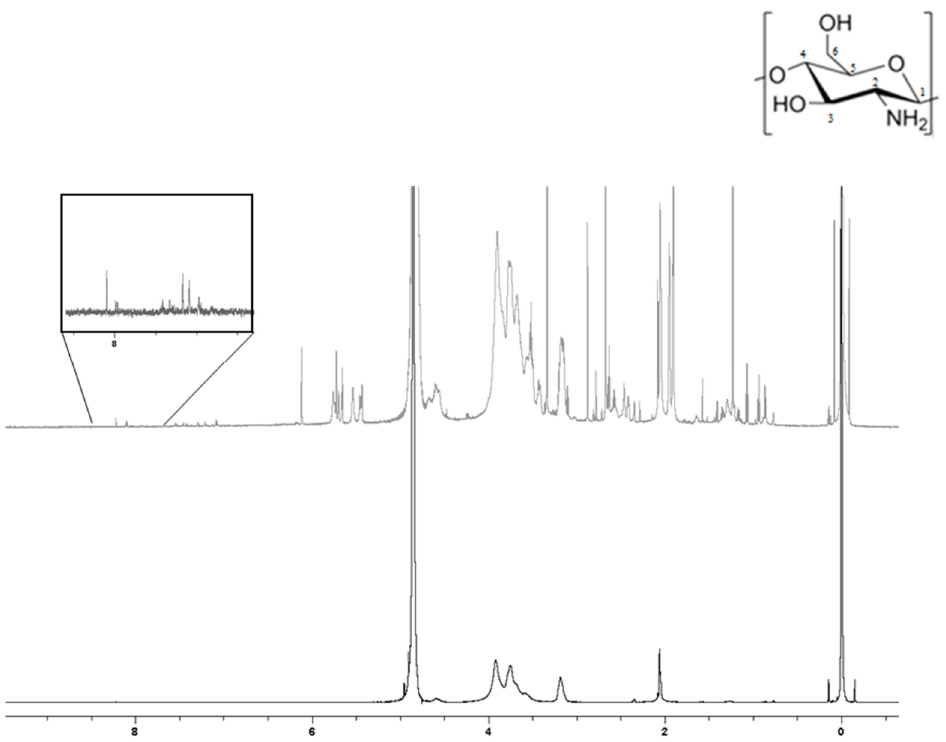
Figure 3. 1 H solution state NMR spectra. (Bottom) Unmodified CS. (Top) Modified CS.